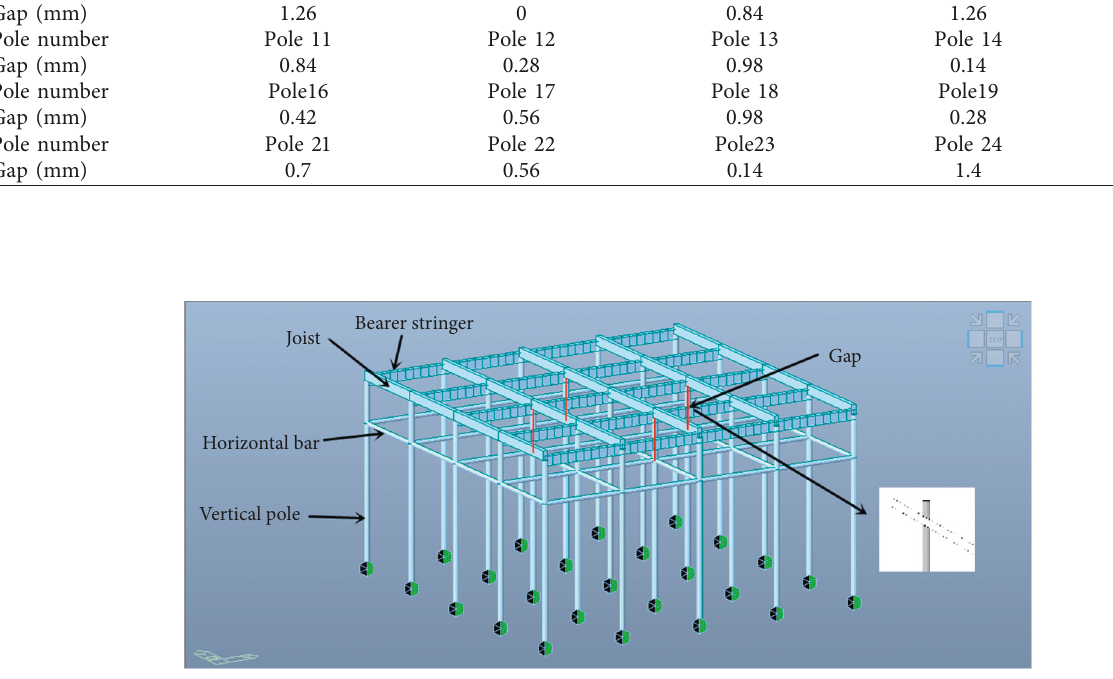
Figure 5: Calculation and analysis model of